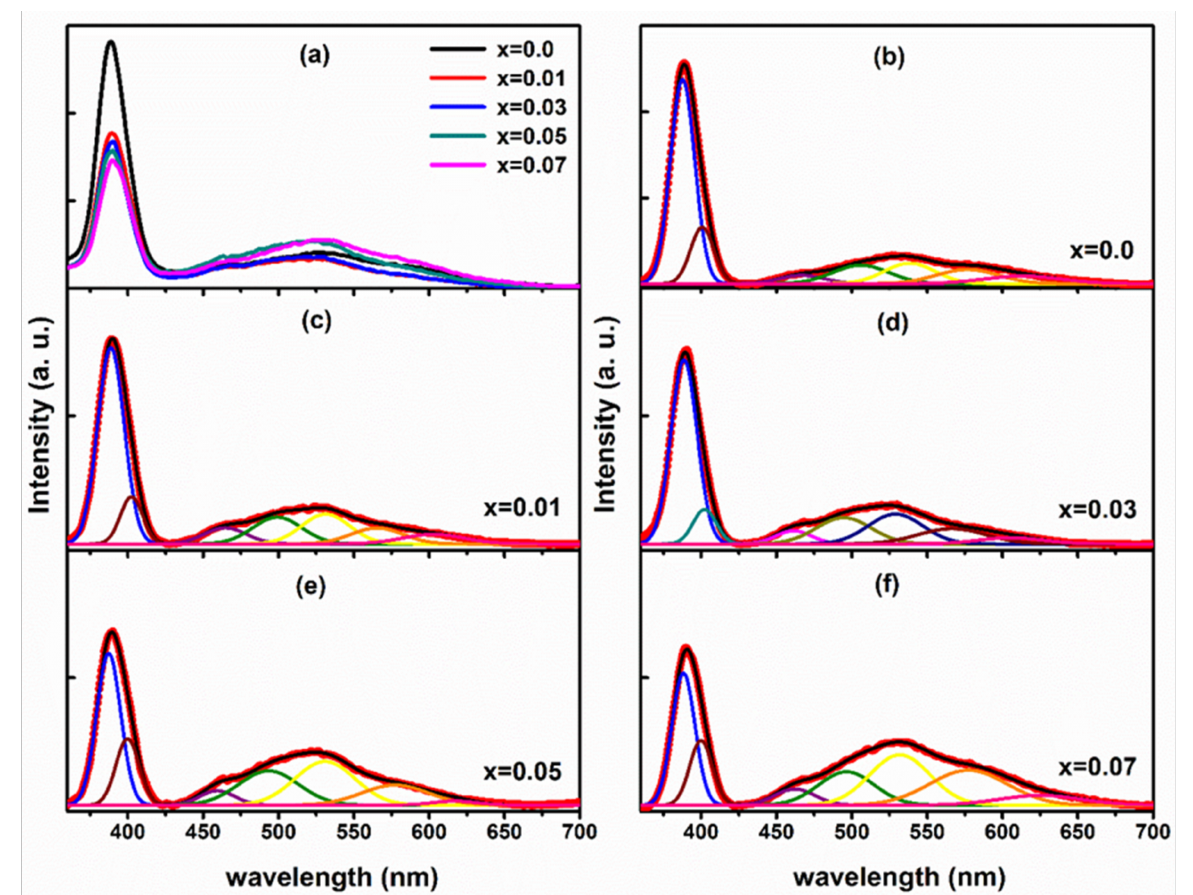
Figure 8. ( a ) Photoluminescence spectra of Zn 1 − x Li x O nanostructured samples. ( b – f ) Deconvoluted photoluminescence spectra of Zn 1 − x Li x O nanostructured